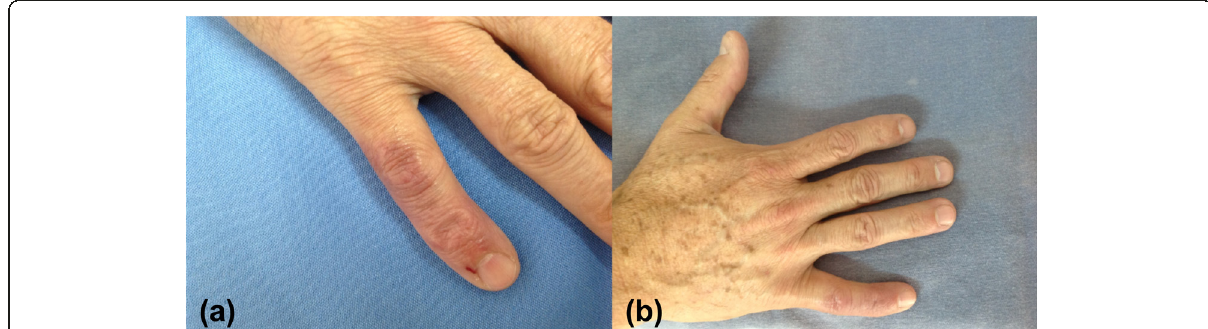
Figure 4 Evolution during and after treatment. (a) Dorsum of the fifth right finger, one month after the beginning of treatment . (b) Dorsum of the right finger, three months after initiation of